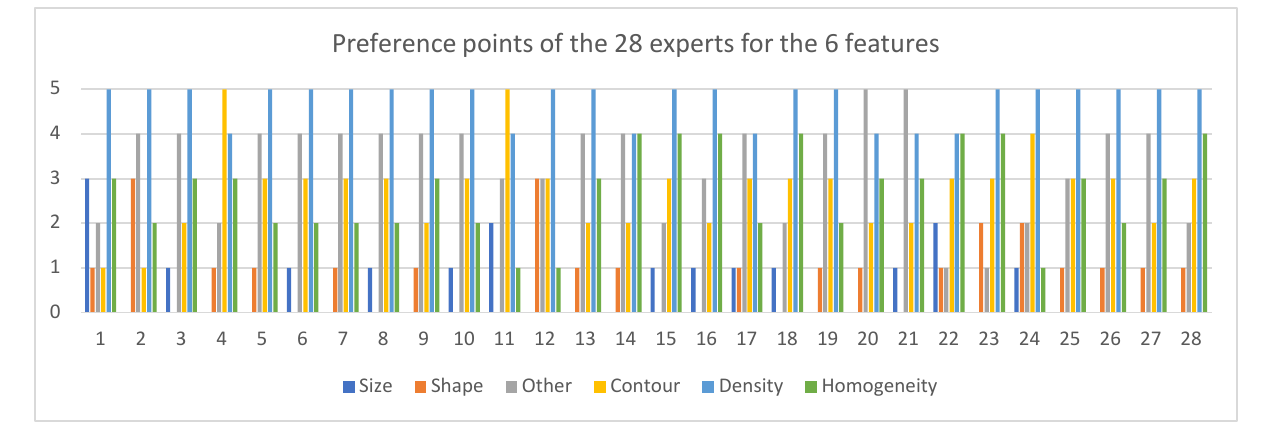
Figure 2. The results of the questionnaire for the 28 experts and 6 attributes. The different experts are denoted by the numbers 1 to 28 on the horizontal axis and the attributes by the colors of the columns, according to the legend at the bottom of the plot.